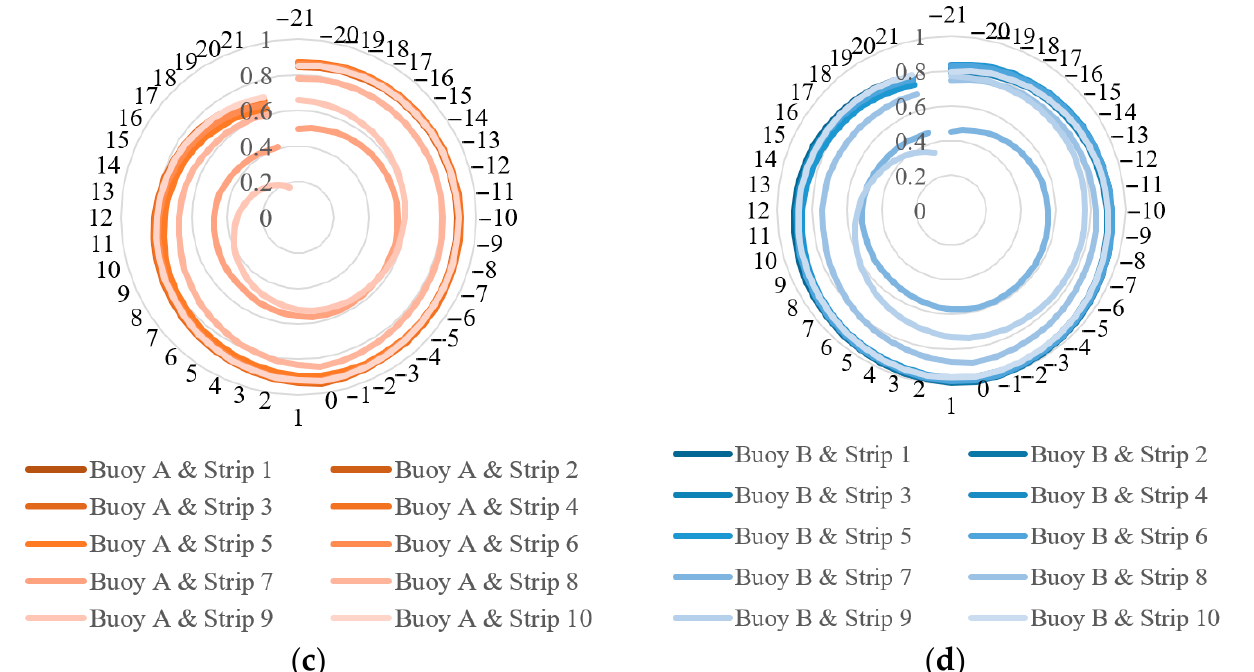
Figure 8. Positive and negative moving diagrams, scatter diagram, and radar diagram for cross-correlation coefficient between buoy spectrometer and UAV spectral data. ( a , b ) show that the central wavelength positions of the two sensors are basically the same, because the correlation coefficient RMS shows a downward trend with the left and right shifts of the wavelength. The important conclusion is that the characteristic band found by the buoy sensor on the water surface can be extended to UAV data. ( c , d ) show that the correlation coefficients of individual strips jump to a large extent with the movement of the central wavelength, which is likely due to the sudden change of light or shadow. These bands need to be eliminated during modeling, otherwise they may cause overfitting or underfitting.